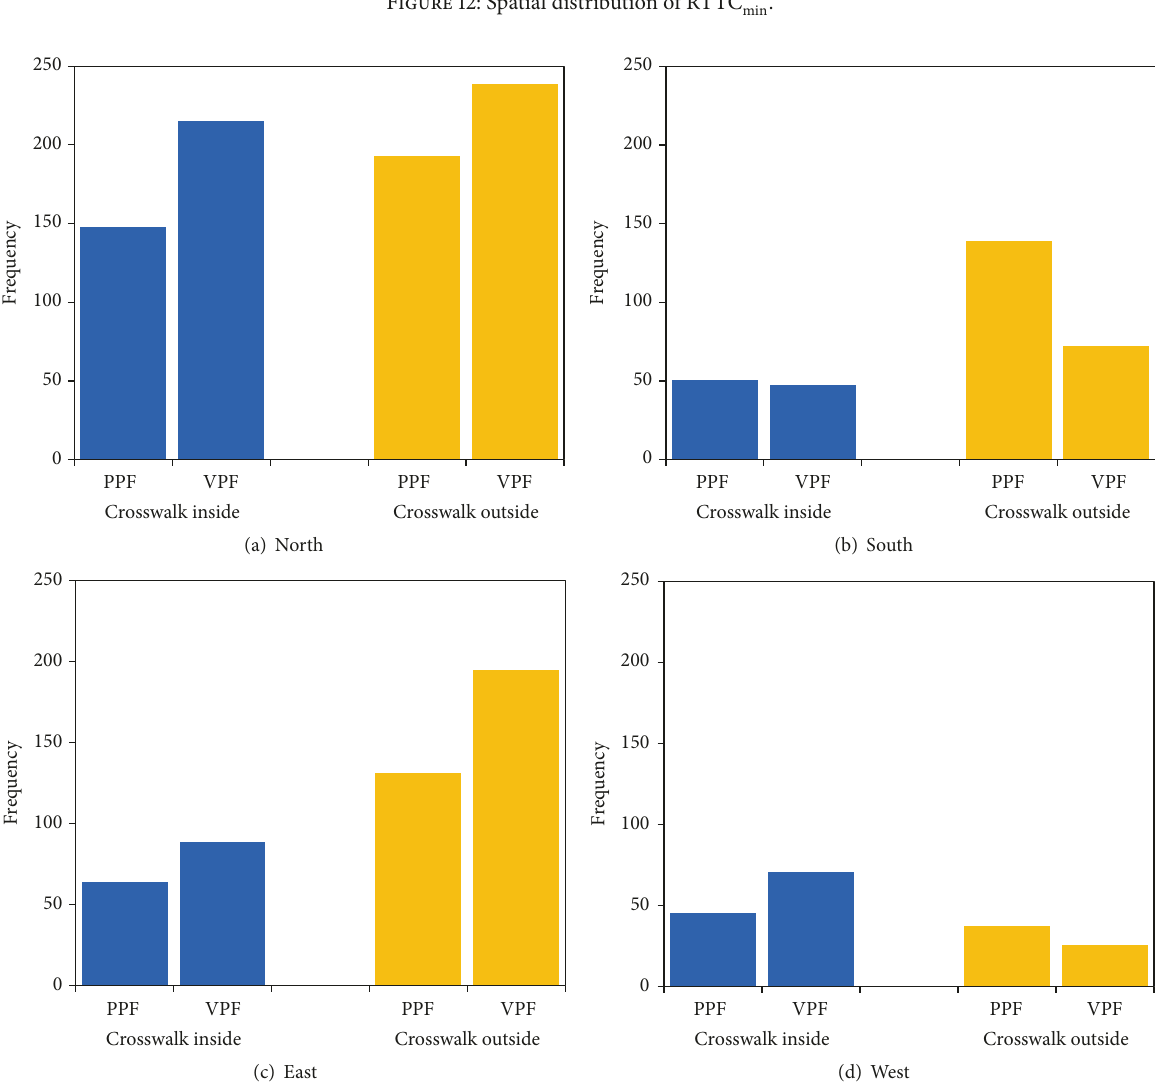
Figure 13: The number of critical RTTC inside and outside of the